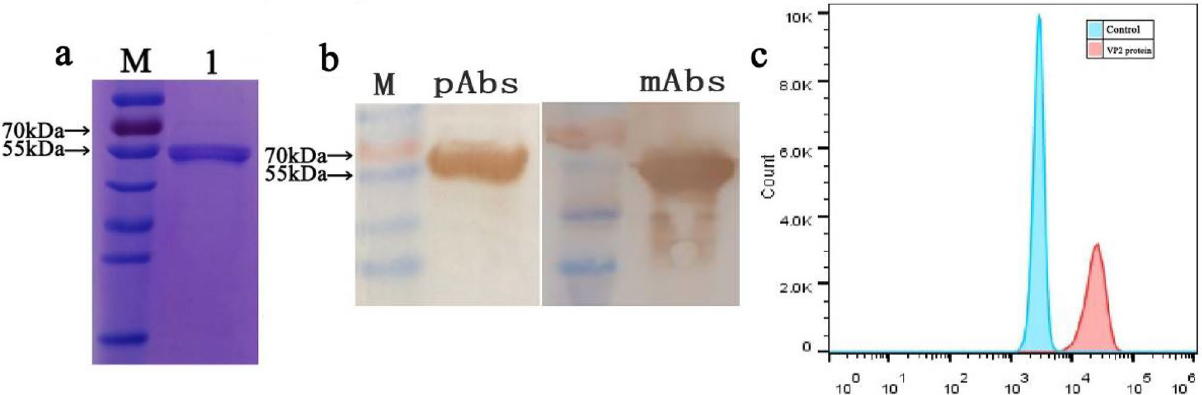
Figure 1. Preparation and quantification of AMDV VP2-modified magnetic beads. ( a ) Purified His-tagged AMDV VP2 protein detected by SDS-PAGE; ( b ) Purified VP2 protein recognized by VP2-specific mAbs and pAbs using western blot assay; ( c ) Flow cytometry showing efficiency of coupling of magnetic beads with VP2